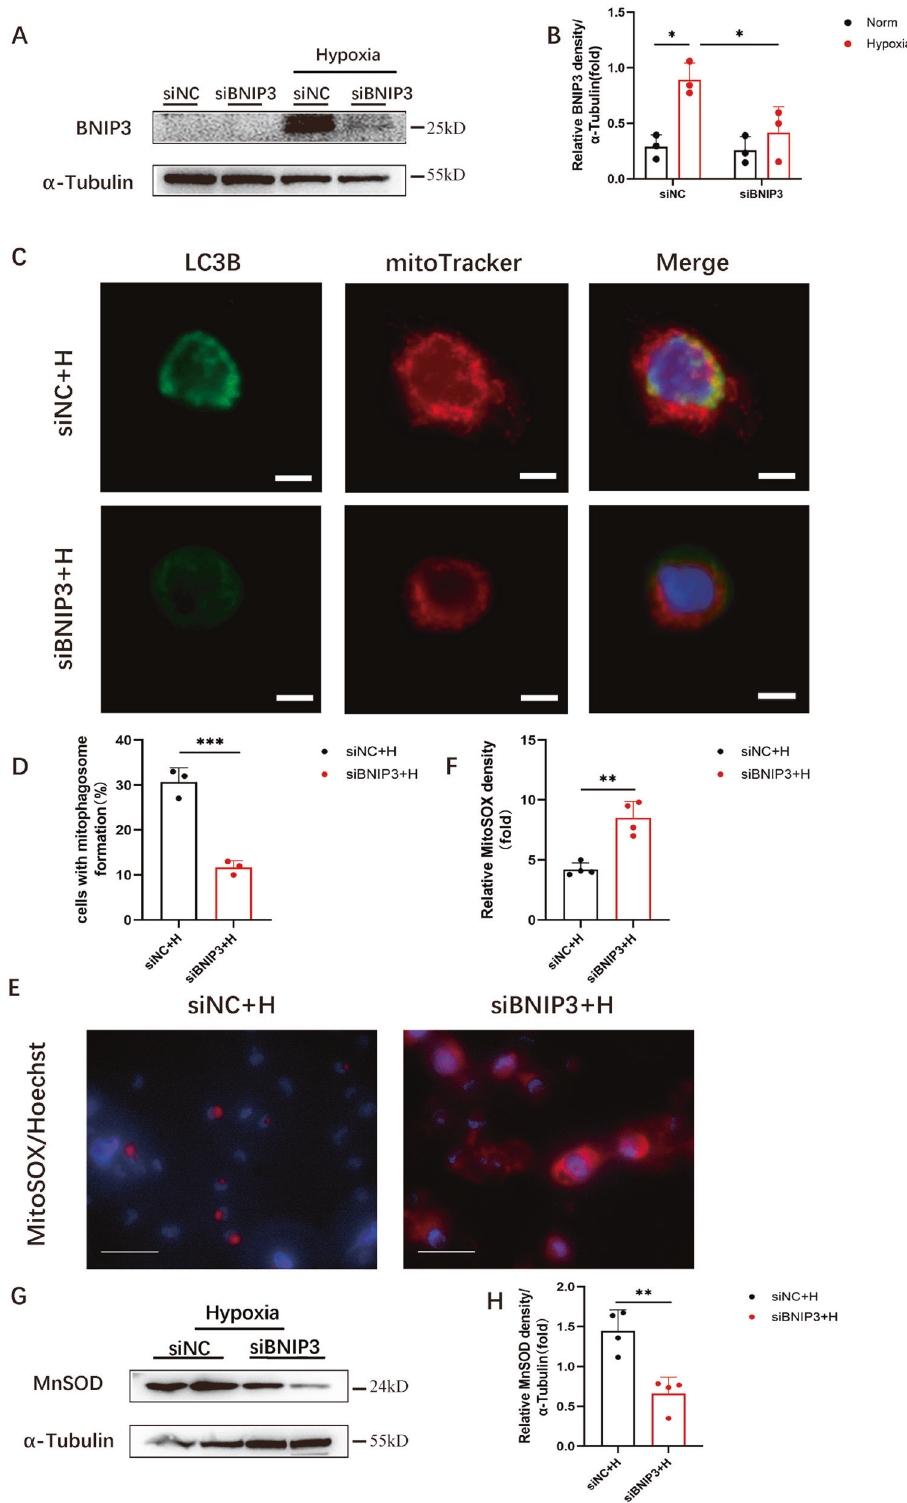
Fig. 4 BNIP3 de fi ciency decreased BNIP3-mediated mitophagy and enhanced mitochondrial ROS production in hypoxia-induced HK-2 cells. A After transfected by negative control siRNA or BNIP3 siRNA, HK-2 cells were under the condition of hypoxia for 24 h. Immunoblot analysis and B quanti fi cation of BNIP3 ( n = 3 per group). C , D Representative images and quanti fi cation of immuno fl uorescence double- labelling LC3B and mitochondrial marker (Mitotracker) ( n = 3 per group). Scale bar: 10 μ m. E Representative images of MitoSOX/Hoechst staining of HK-2 cells and F quanti fi cation data of fl uorescence density ( n = 4 per group). Scale bar, 50 μ m (×400) G Immunoblot analysis of MnSOD in lysates of HK-2 cells, and H quantitative data of immunoblotting ( n = 4 per group). Error bars: SEM. * p < 0.05; ** p < 0.01; *** p < 0.001. siNC + H, siNC + Hypoxia. siBNIP3 + H, siBNIP3 + Hypoxia.